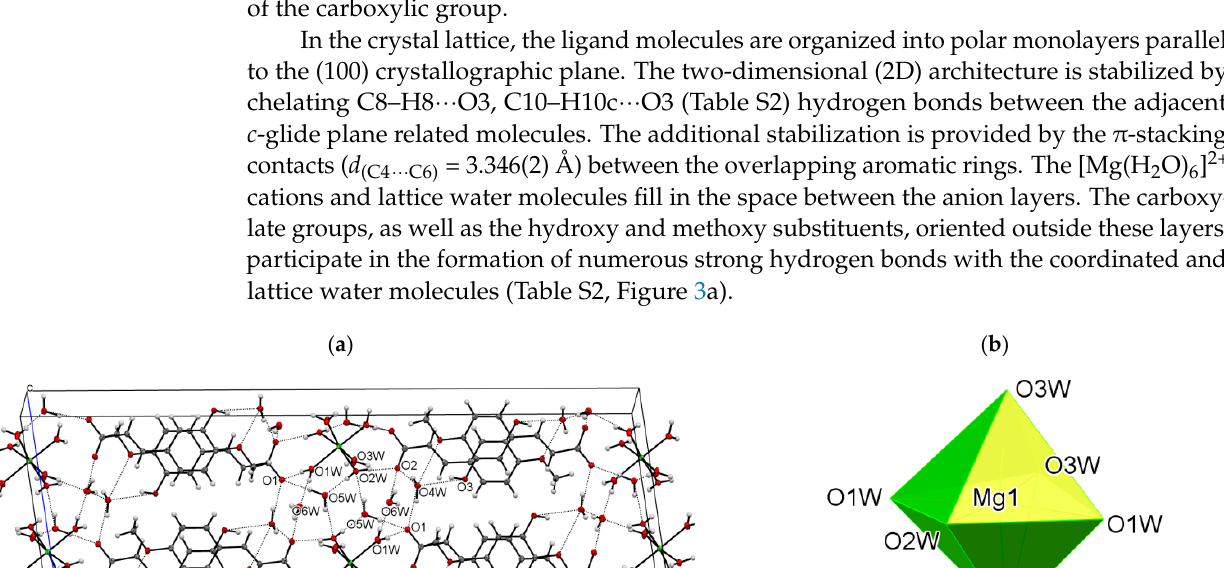
Figure 3. ( a ) The alternating cationic and anionic (100) layers in Mg(II) IFA, viewed along the b axis. Dashed lines indicate hydrogen-bonding interactions. ( b ) The polyhedral representation of [Mg(H 2 O) 6 ] 2+ cation.